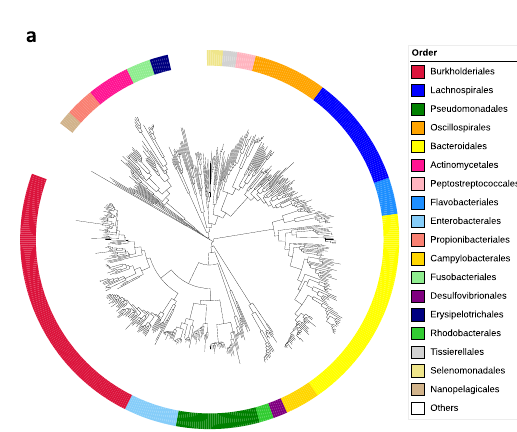
Fig. 6 | Taxonomic annotations of MAGs and the apparent infection spectrum of vMAGs from the domestic wastewater sample. ( a ) Taxonomic annotations of MAGsrecoveredbyHiCBinfromthedomesticwastewatersample. Burkholderiales , Pseudomonadales , Lachnospirales , Bacteroidales , and Oscillospirales were the pre- dominant orders. ( b ) The apparent infection spectrum of vMAGs from the